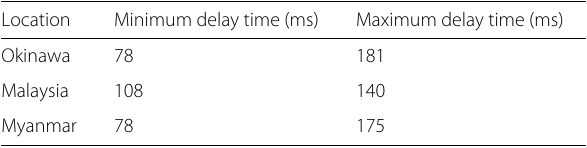
Table 2 Voice communication test result between Gwangju metro-city and South-East Asian locations